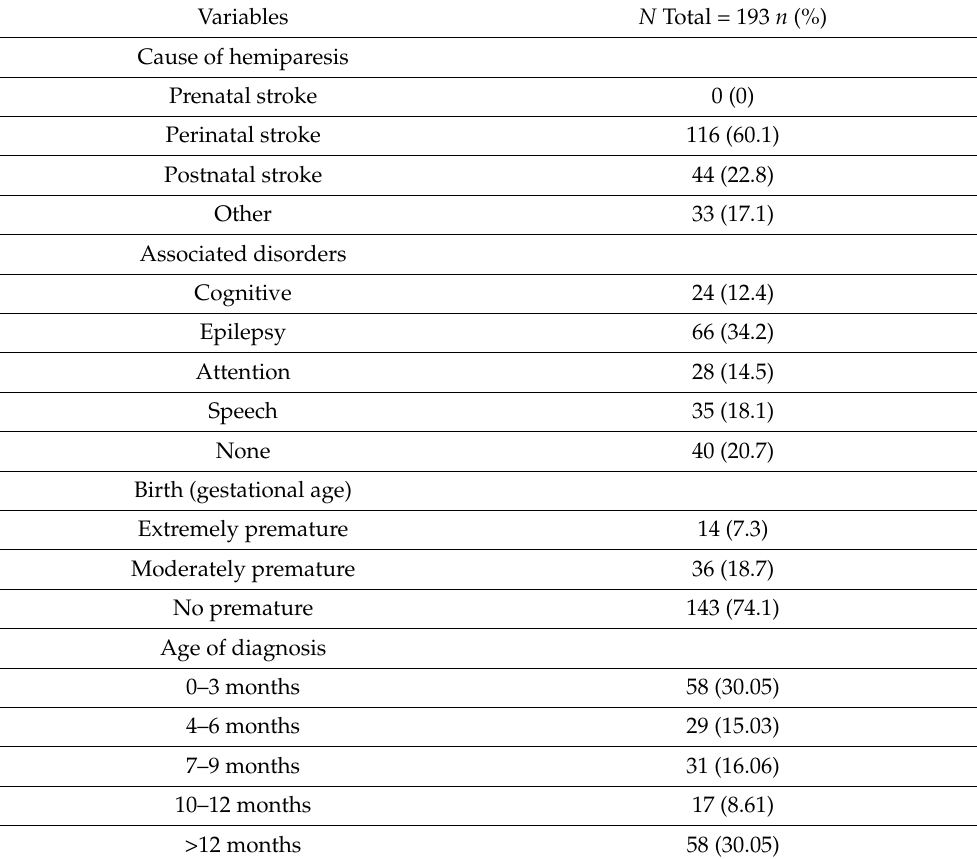
Table 2. Frequencies of the study